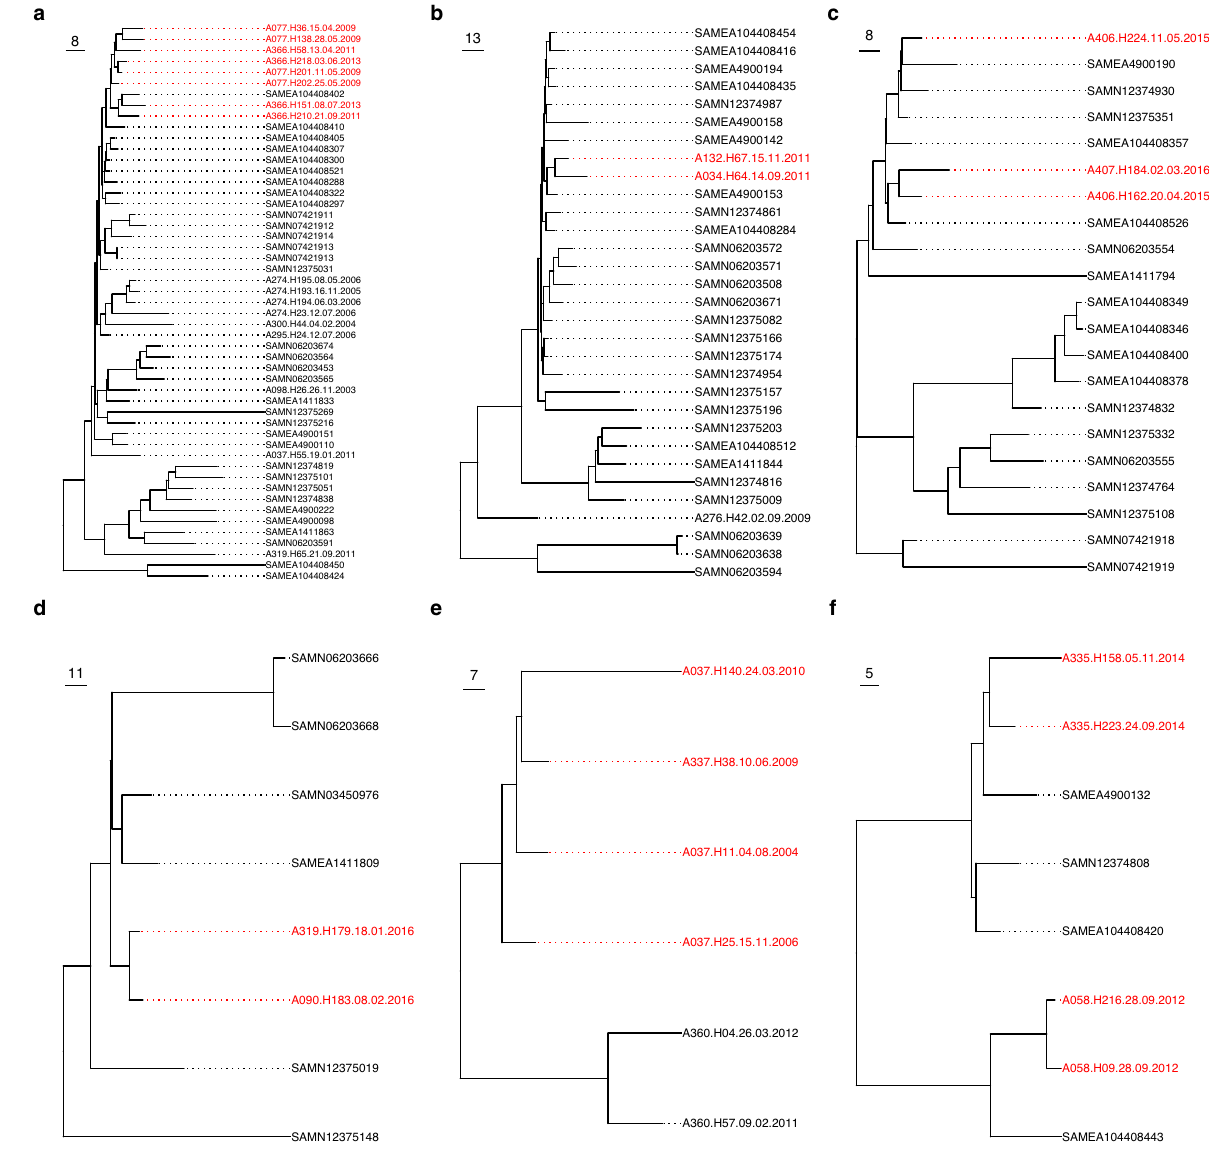
Figure 4. Neighbor-joining trees for STs with patient-pairs of interest generated using differences in gene content. ( a ) ST-12, ( b ) ST-103, ( c ) ST-145, ( d ) ST-321, ( e ) ST-393, and ( f ) ST-1034. Isolates colored red belong to patient-pairs of interest. Public genomes are labelled with their BioSample accessions. Isolate names are given in the format “Patient Number”-“Isolate Number”-“Collection Date (DD-MM-YYYY)”. Scale bars for each tree are given in number of differences in gene